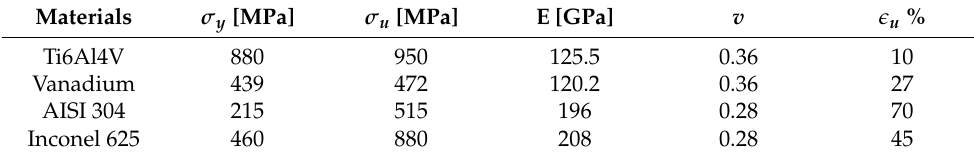
Table 2. Mechanical properties of the materials composing the welded plate [42,43].